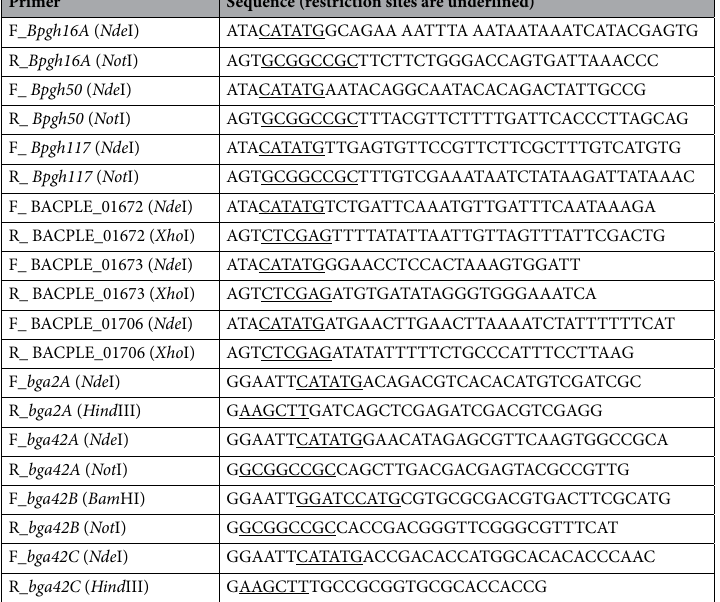
Table 1. Primers used in this study.